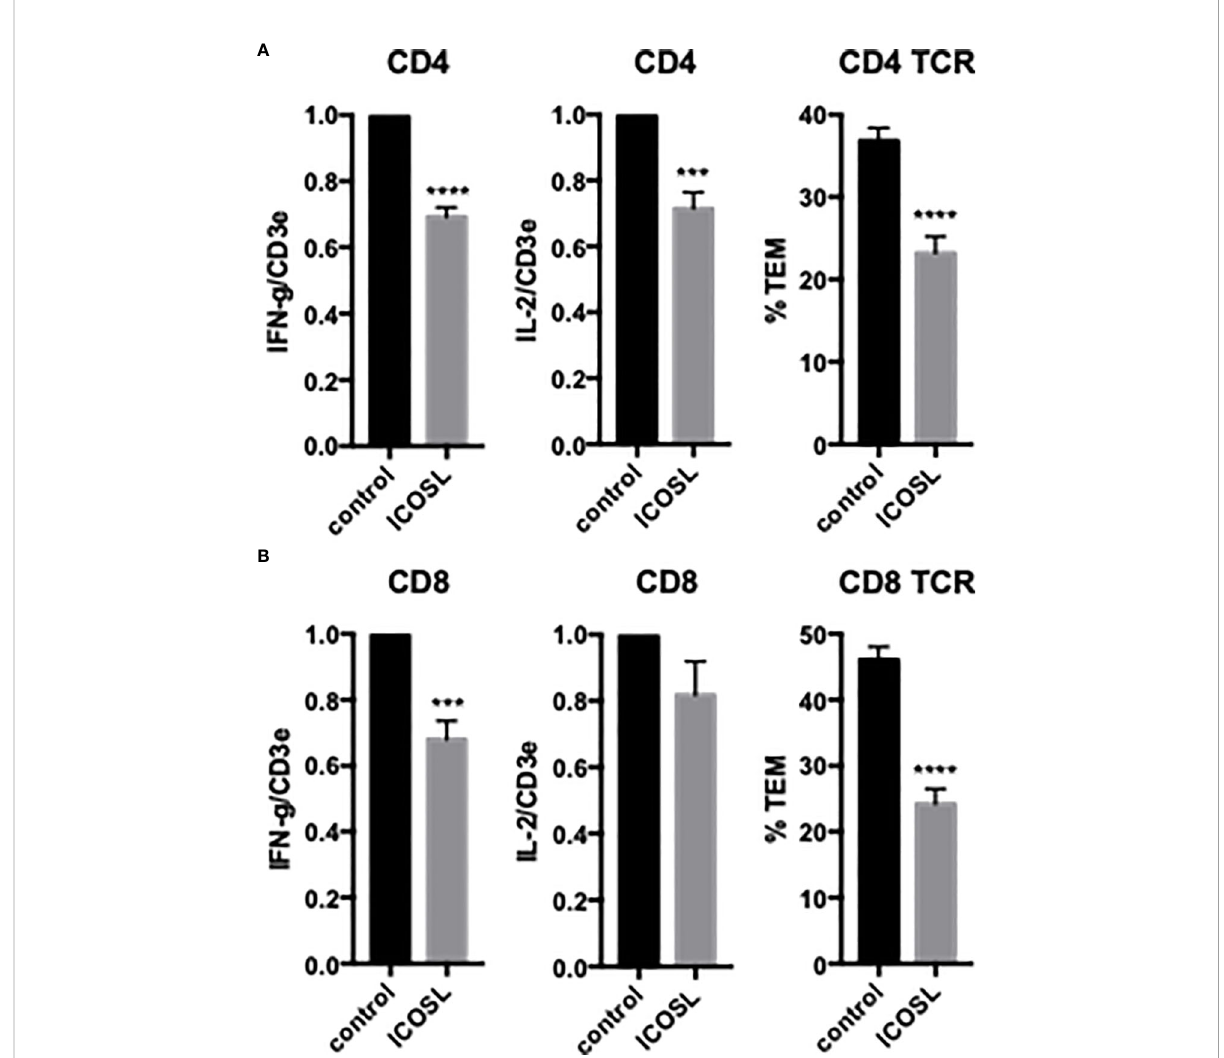
FIGURE 2 Effects of EC ICOSL on cytokine expression and TCR-TEM of CD4 and CD8 T EM . CD4 (A) and CD8 (B) T EM were assayed as in Figure 1 on CIITA HDMEC treated with control or ICOSL siRNA. ***p<0.001;